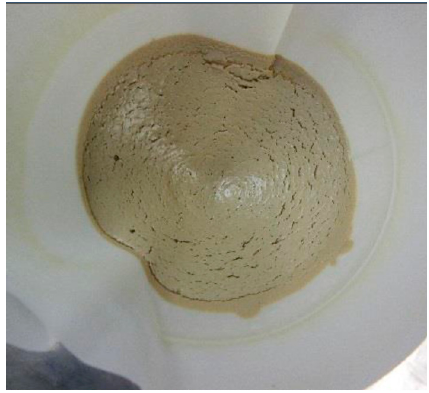
Figure 3. Clean barium sulphate on filtration paper.